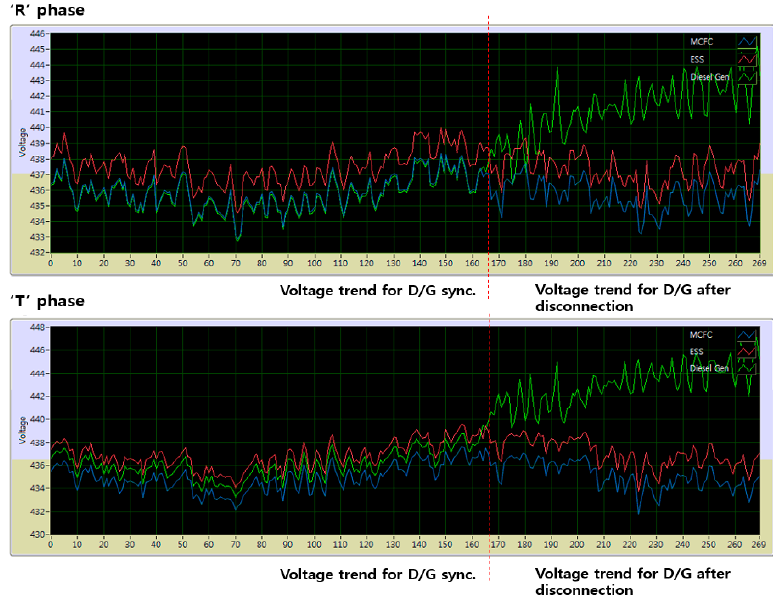
Figure 22. Voltage change when diesel generators are broken away.